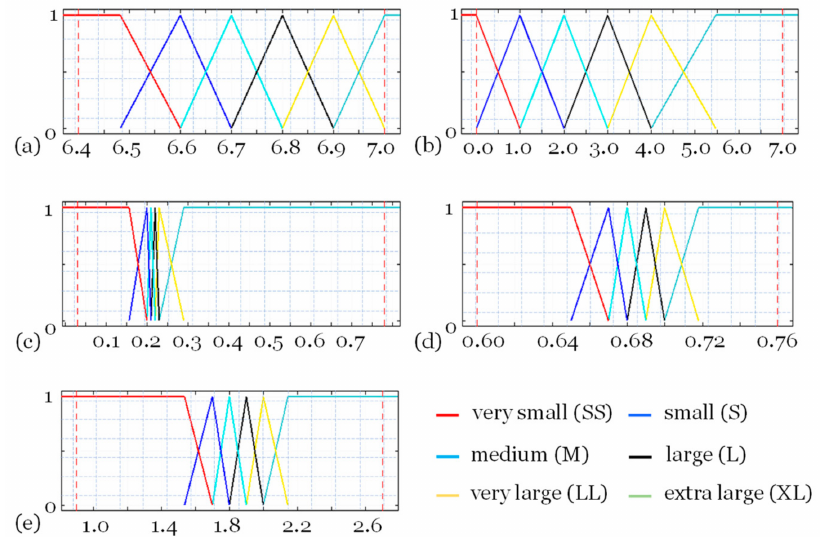
Figure 7. Fuzzification of the predictor variables in the input space using triangular membership functions and 6 linguistic values (SS, S, M, L, LL, and XL): ( a ) pH, ( b ) color (HU), ( c ) turbidity (NTU), ( d ) fluoride (mg/L), and ( e ) chloride